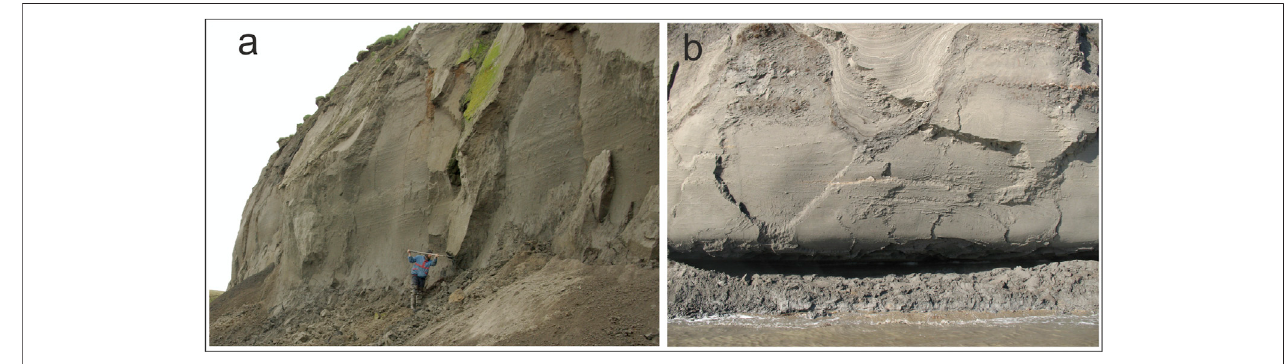
FIGURE 7 | Kuchchugui deposits: (A) syncryogenic cryofacies on Oyogos Yar (yellow-greenish color mark modern lichens on the outcrope`s wall) and (B) taberated cryofacies (under Krest-Yuryakh`s casts) on Bol`shoy Lyakhovsky Island.